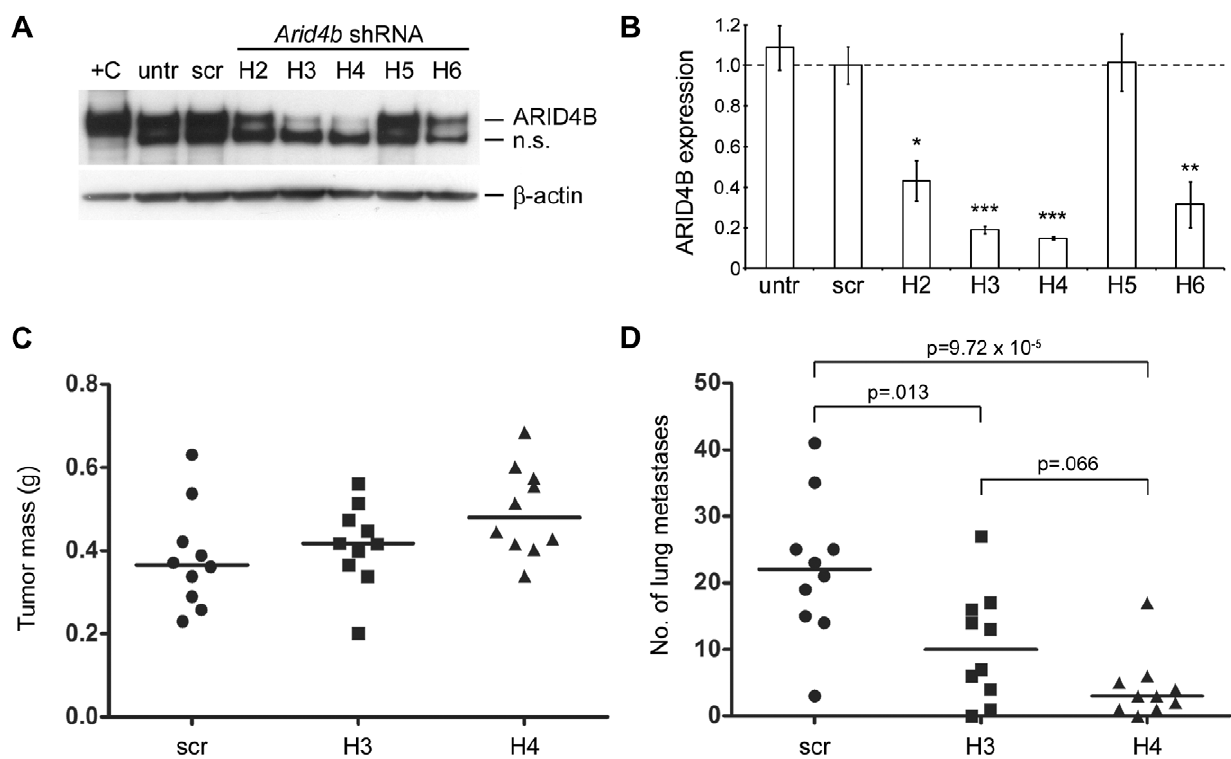
Figure 4. Stable shRNA–mediated knockdown of Arid4b inhibits lung metastasis. ARID4B protein levels were analyzed by western blot to determine level of knockdown in cell lines stably expressing different Arid4b shRNAs. Experiment was performed in triplicate and a representative blot is shown in panel A. Lysate from 293 cells transiently transfected with Arid4b was used as a positive control ( + C). Untransduced 6DT1 and scrambled control lines are designated ‘‘untr’’ and ‘‘scr’’ respectively. The lower non-specific (n.s.) band most likely represents ARID4A, based on a nearly identical epitope sequence and consistent with the observed difference in molecular weight. Expression of the non-specific band remained relatively unchanged across the panel of stable lines. Densitometry was performed to quantitate knockdown at the protein level in the Arid4b shRNA lines relative to the scrambled control line (B) Data are shown as the mean 6 standard error of three independent experiments. Kruskal-Wallis followed by Conover-Inman post hoc tests were used to determine statistical significance versus the scrambled control cell line. *, p , .05; **, p , .01; ***, p , .001. Primary tumors were weighed (C) and lung surface metastases were counted (D) at 3.5 weeks after orthotopic implantation of 10 ‘ 5 cells from the scrambled control, H3, and H4 lines into the mammary fat pad of FVB mice (n=10 per cohort). Horizontal bars represent median values and statistical significance was determined using Kruskal-Wallis tests followed by Conover-Inman correction for multiple comparisons.